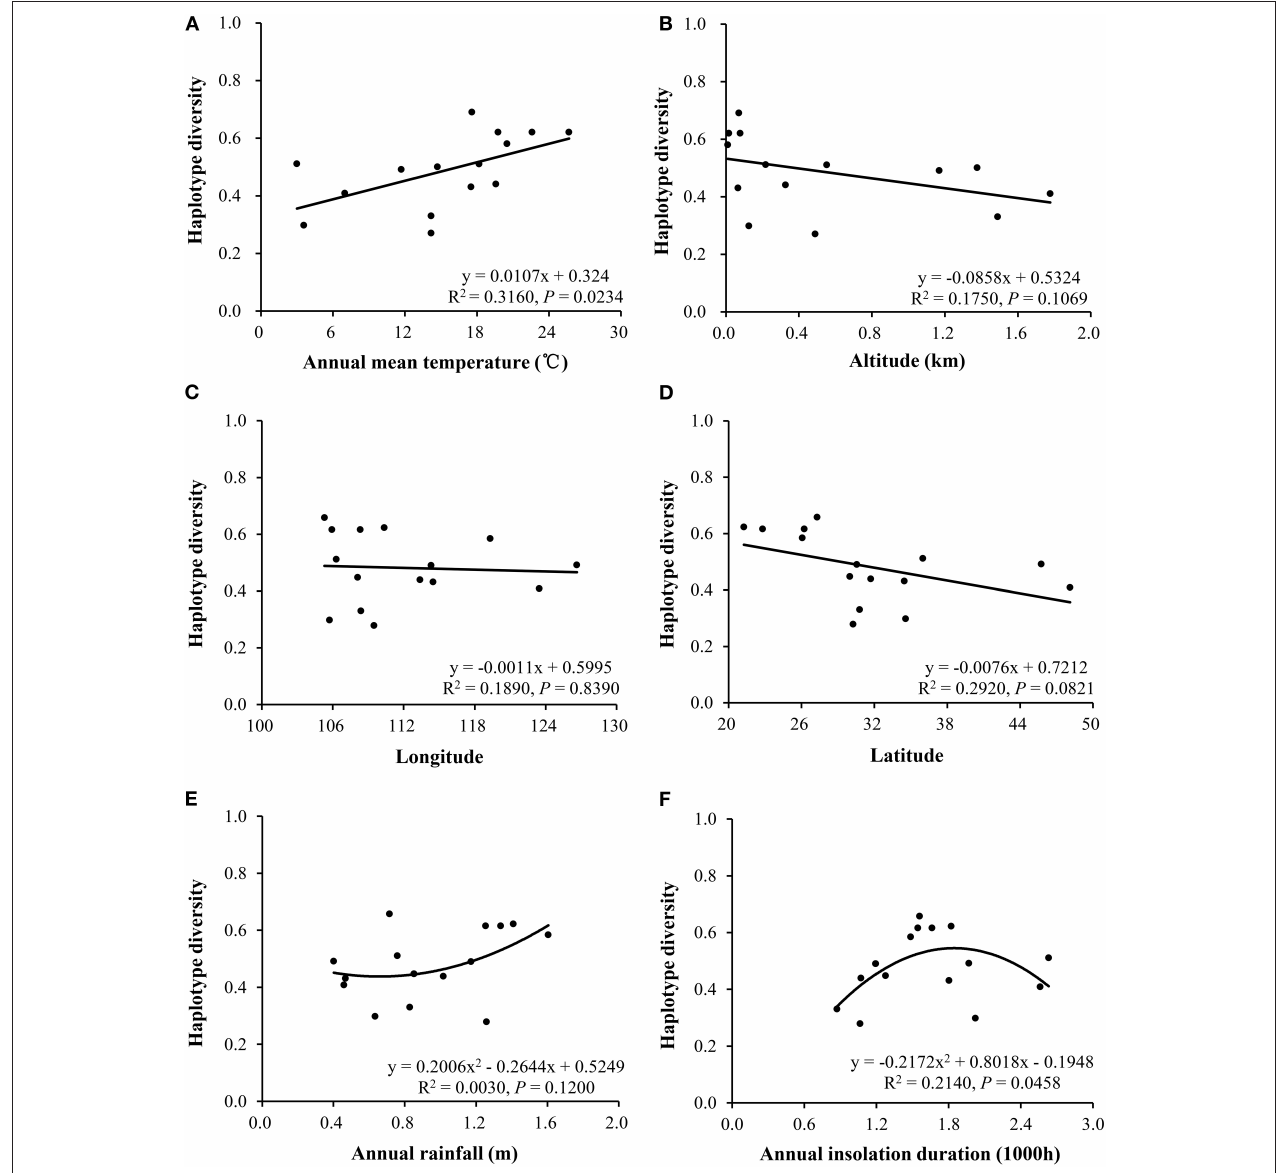
FIGURE 4 | Correlation of annual mean temperature, altitude, latitude, and annual insolation duration of the collection sites with haplotype diversity in the P. infestans populations collected from China: (A) annual mean temperature, (B) altitude, (C) longitude, (D) latitude, (E) annual rainfall, and (F) insolation.